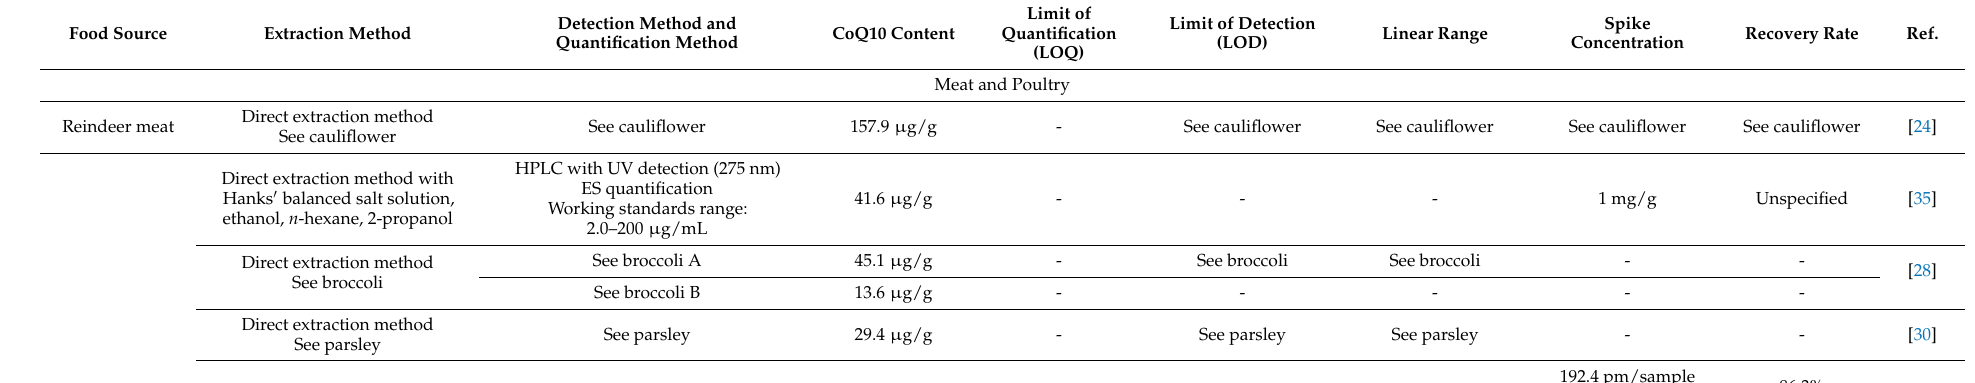
Table 2. Contents of CoQ10 in products of animal